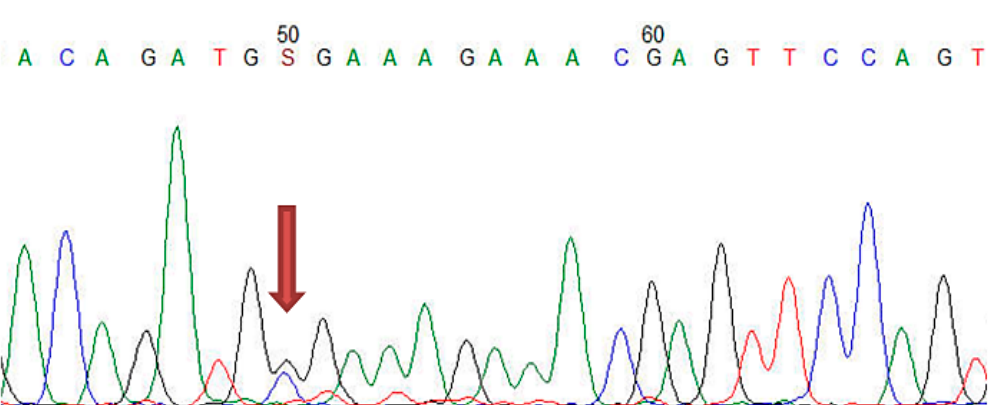
Figure 2. The Sanger sequencing electropherogram in patients H18 and H42: pathogen mutation of LDLR in exon 2 (c.81C >